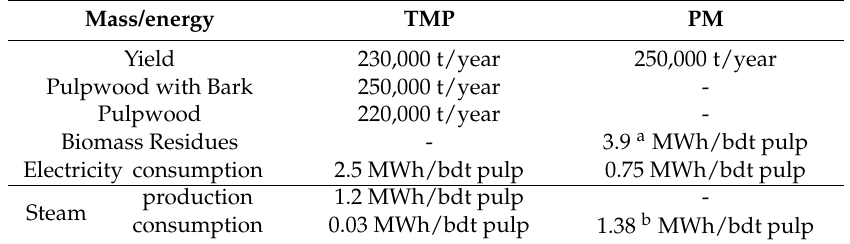
Table 1. Outline of a thermomechanical pulp (TMP) and paper mill (PM) [8].